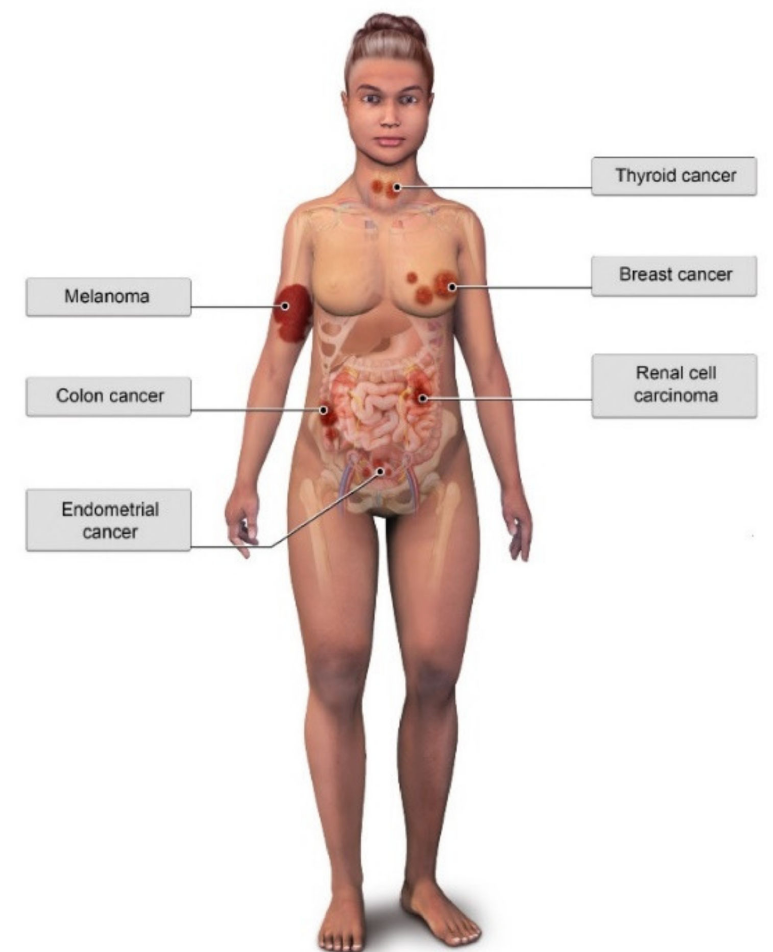
Figure 5. Illustration of common malignant pathologies associated with Cowden